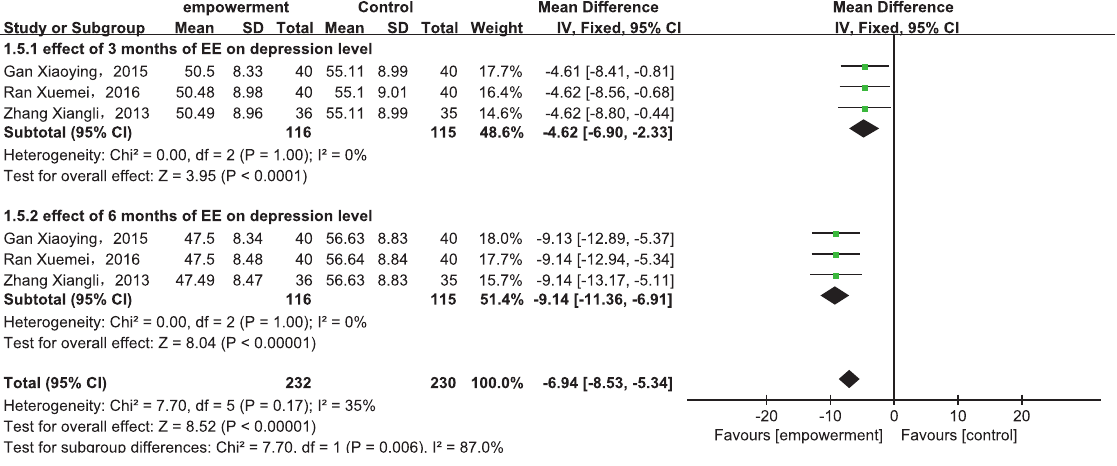
Figure 5. Comparison of depression levels between empowerment education intervention group and traditional education